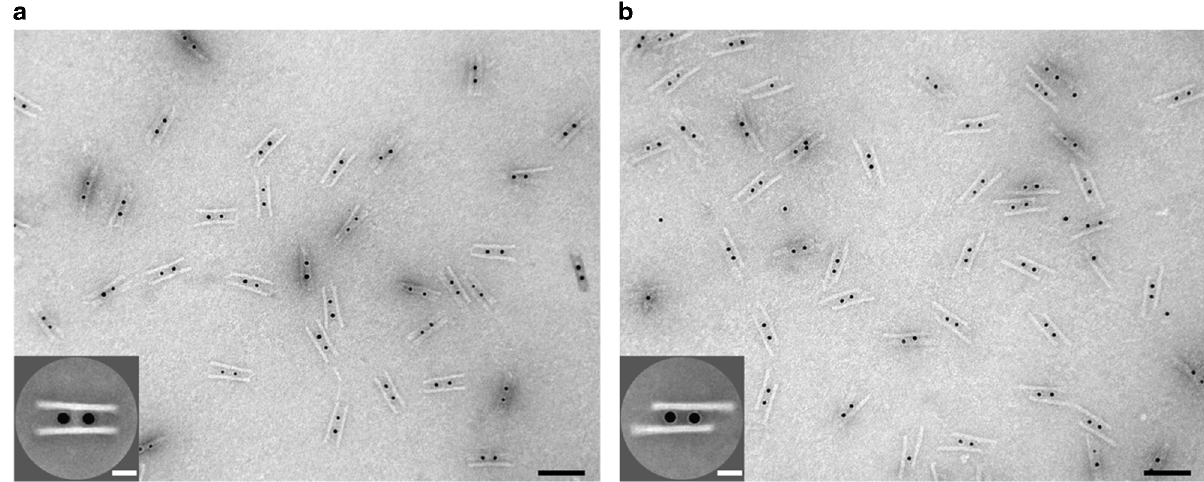
Fig. 2 TEM images of the AuNC-origami structures. a TEM image of the structures before sliding. In the individual structures, two AuNCs are assembled in between two DNA origami fi laments. Scale bar, 100 nm. Inset: averaged TEM image. Scale bar, 20 nm. b TEM image of the structures after two sliding steps. Scale bar, 100 nm. Inset: averaged TEM image. Scale bar, 20 nm